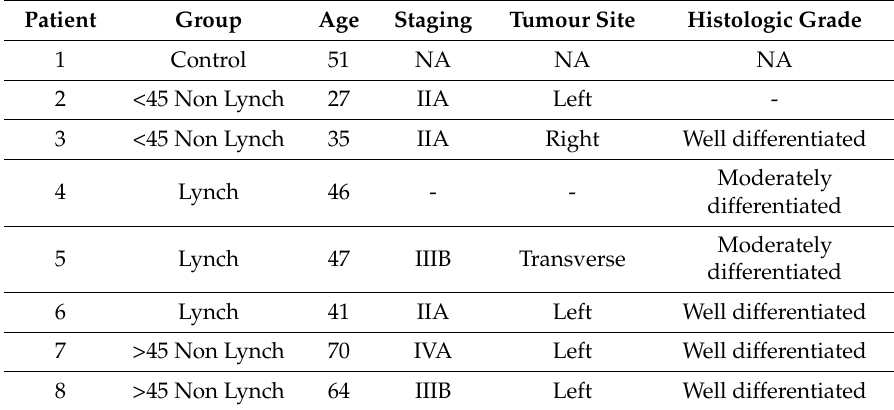
Table 1. Clinical features of patients using in screening analyses. Age, staging, tumour side and histological grade are shown. (NA) not applicable; (-) not available data. Patient Group Age Staging Tumour